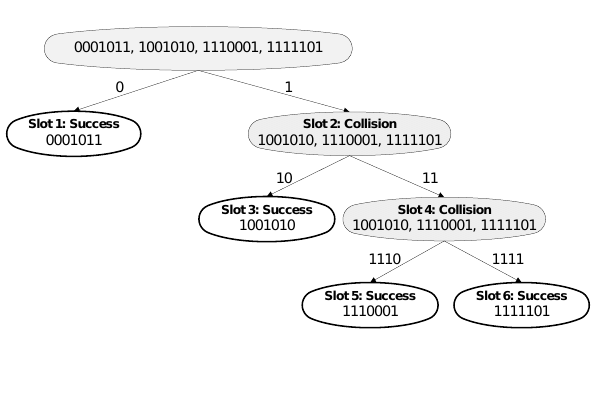
Figure 3. Example of CT